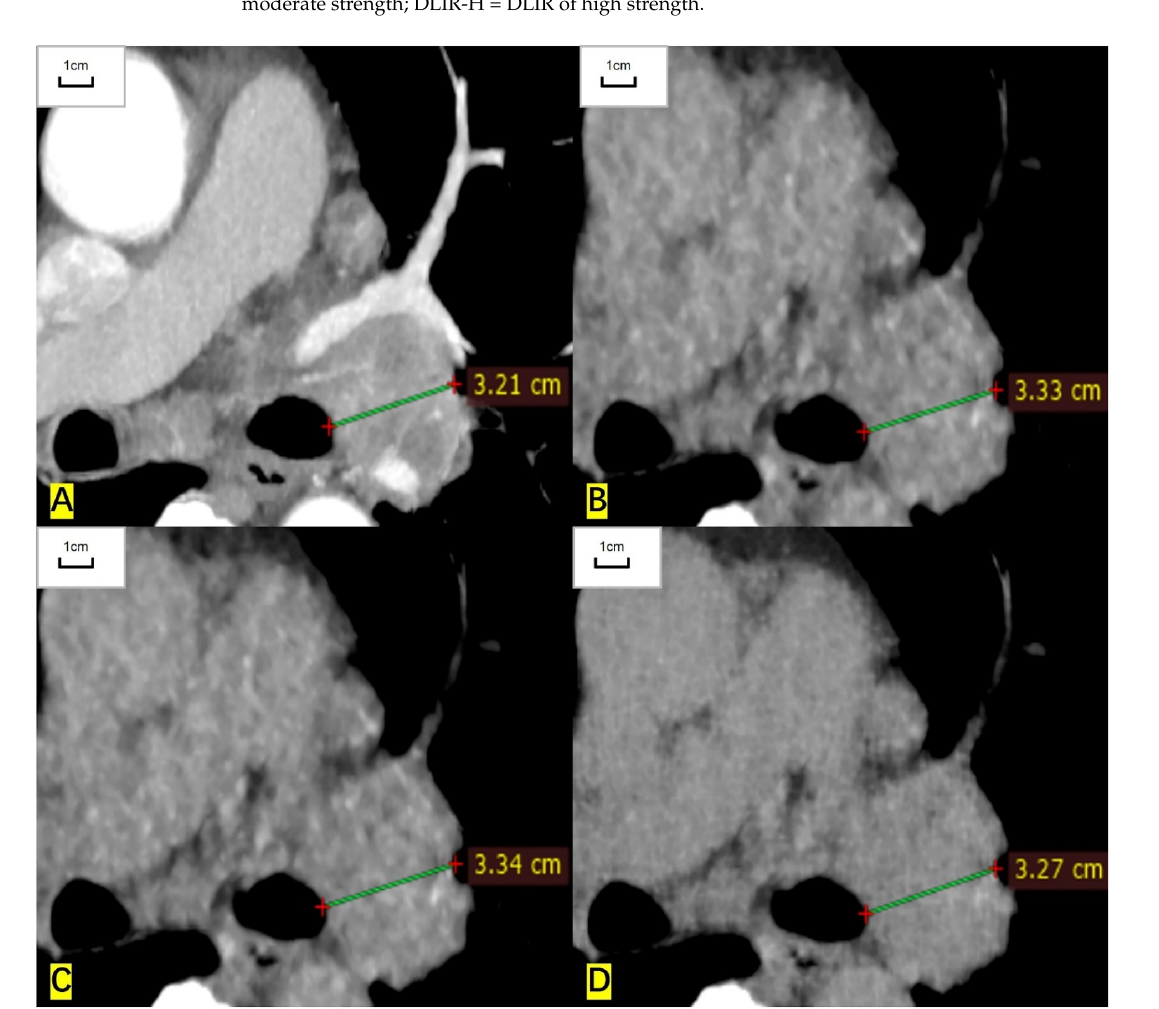
Figure 2. A 75 ‐ year ‐ old woman had a lymph node in the left hilum and the histological result was Figure 2. A 75-year-old woman had a lymph node in the left hilum and the histological result adenocarcinoma. ( A ) The short diameter measured on the contrast ‐ enhanced CT image is 32.1 mm. was adenocarcinoma. ( A ) The short diameter measured on the contrast-enhanced CT image is 32.1 mm. ( B ) The measured short diameter on the ASIR-V-80% reconstructed image is 33.3 mm. ( C ) The measured short diameter on the DLIR-M image is 33.4 mm. ( D ) The measured short diameter on the DLIR-H images is 32.7 mm. The short diameter is overestimated by 3.7%, 4.0%, and 1.9%, respectively, compared with that of contrast-enhanced